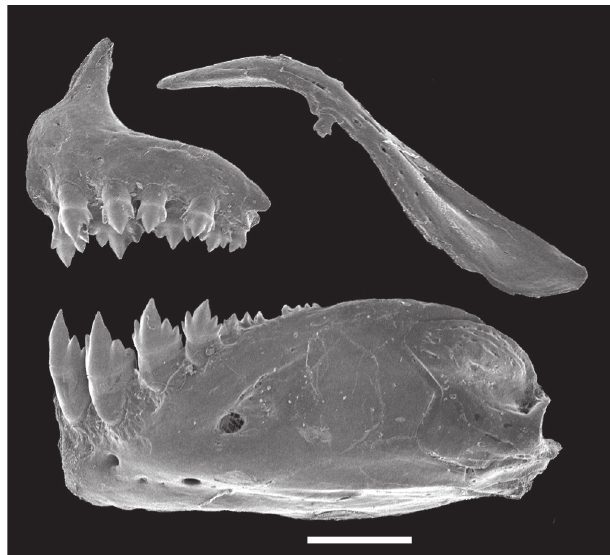
Fig. 6. Astyanax courensis , new species, UFRGS 11290, 45.0 mm SL. Scanning electronic microscopy images of upper and lower jaws, left side, lateral view. Scale bar = 1